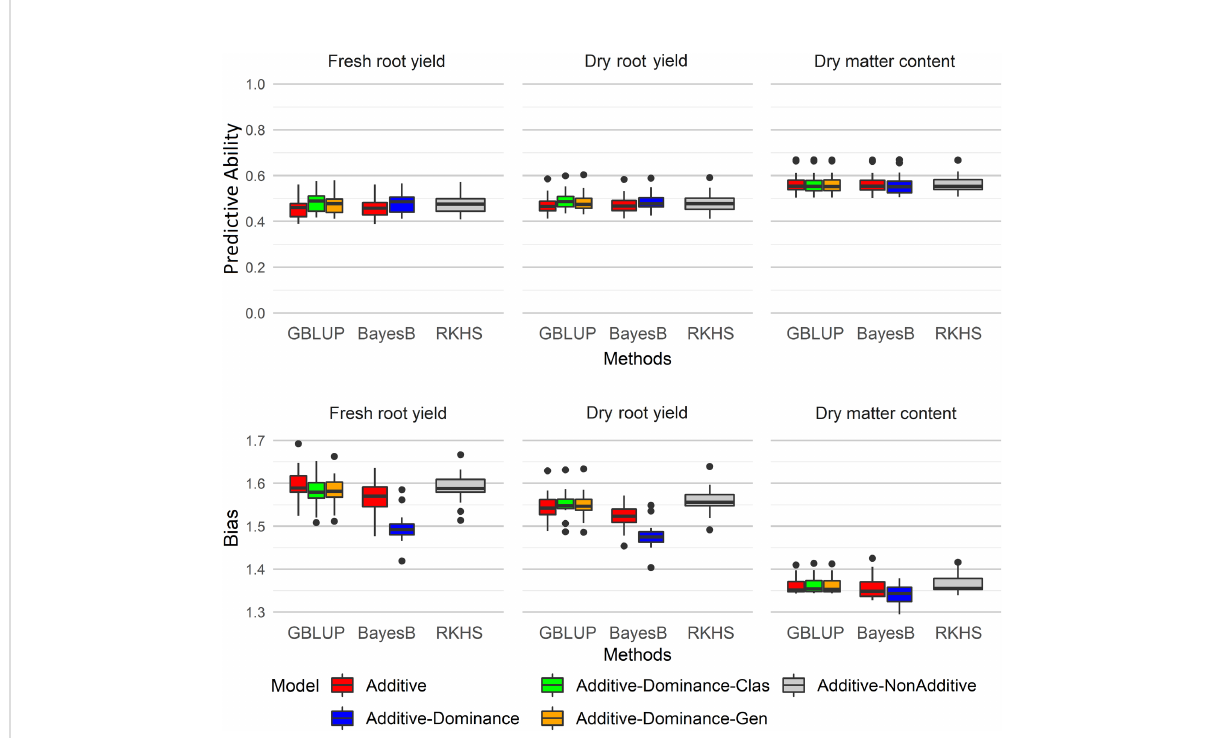
FIGURE 1 SP: selection proportion; SD GS: genomic selection differential; SD PS: phenotypic selection differential; GB/PB: ratio between the breeding cycle assisted by genomic selection and conventional breeding cycle; Ef fi ciency = SD GS /[ SD PS ×( GB / PB )] Boxplots of predictive ability and bias for different genomic selection methods (G-BLUP, Bayes B, and RKHS) with additive and additive-dominant genetic models for fresh root yield (FRY), dry root yield (DRY), and dry matter content (DMC). GBLUP, genomic best linear unbiased prediction; RKHS, reproducing kernel Hilbert spaces.